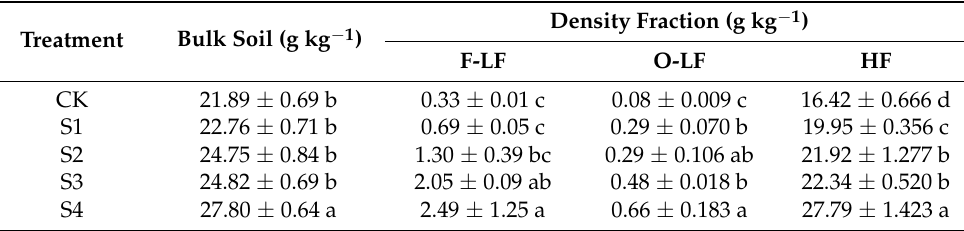
Table 1. Effects of straw return on the content of soil organic carbon (SOC) in bulk soil and the density